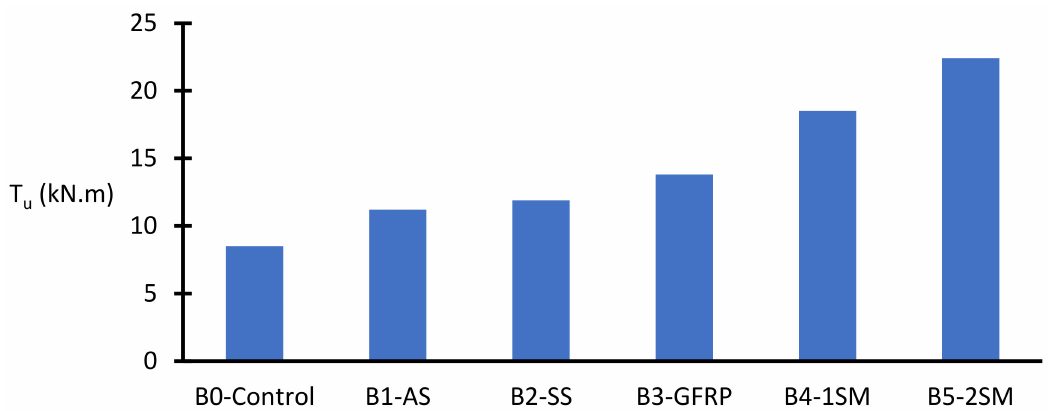
Figure 22. Effect of the strengthening type on the ultimate